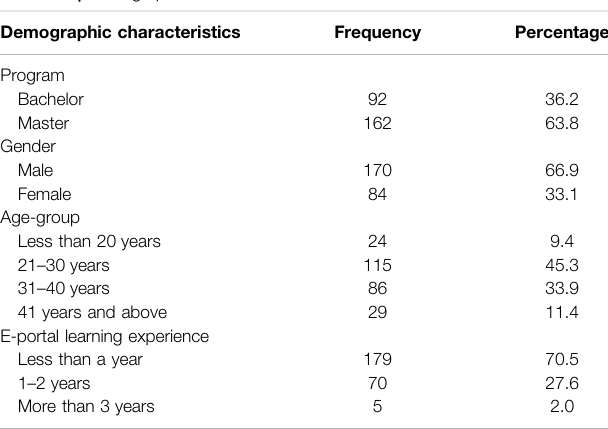
TABLE 1 | Demographic characteristics. TABLE 2 | Full collinearity